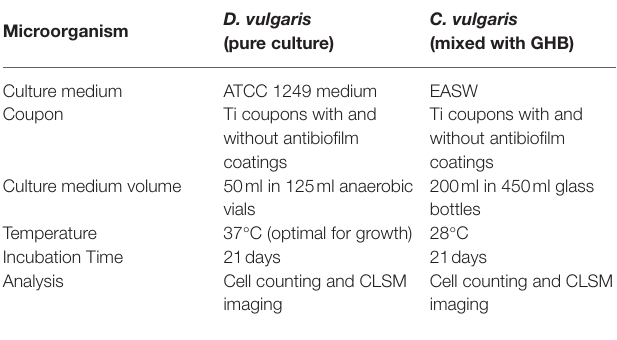
TABLE 1 | Test matrix for SRB and